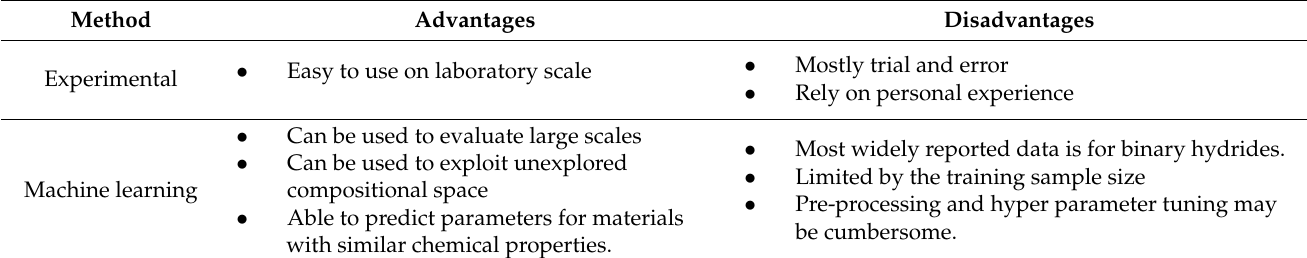
Table 4. Comparison of experimental techniques and machine learning. Method Advantages Disadvantages